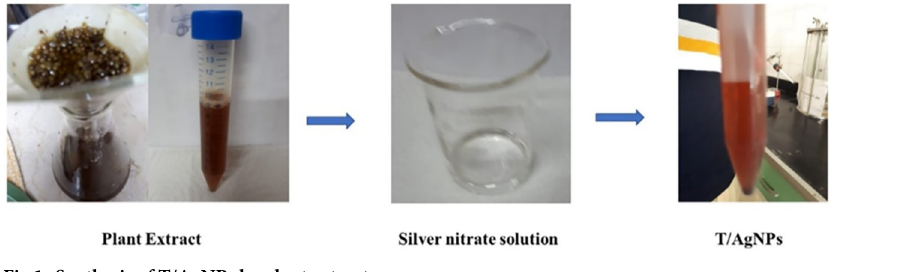
Fig 1. Synthesis of T/AgNPs by plant